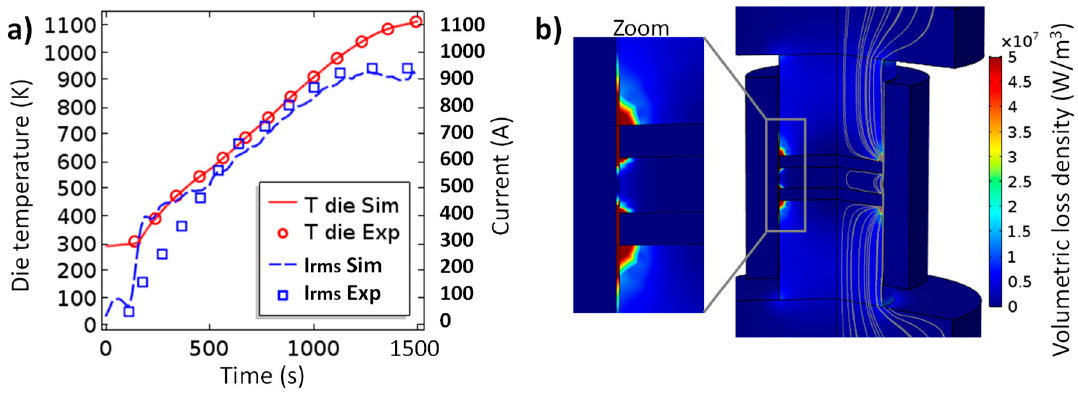
Figure 4. ( a ) Compared experimental/simulated die temperature and electric current; ( b ) simulated electric current lines and volumetric loss density.